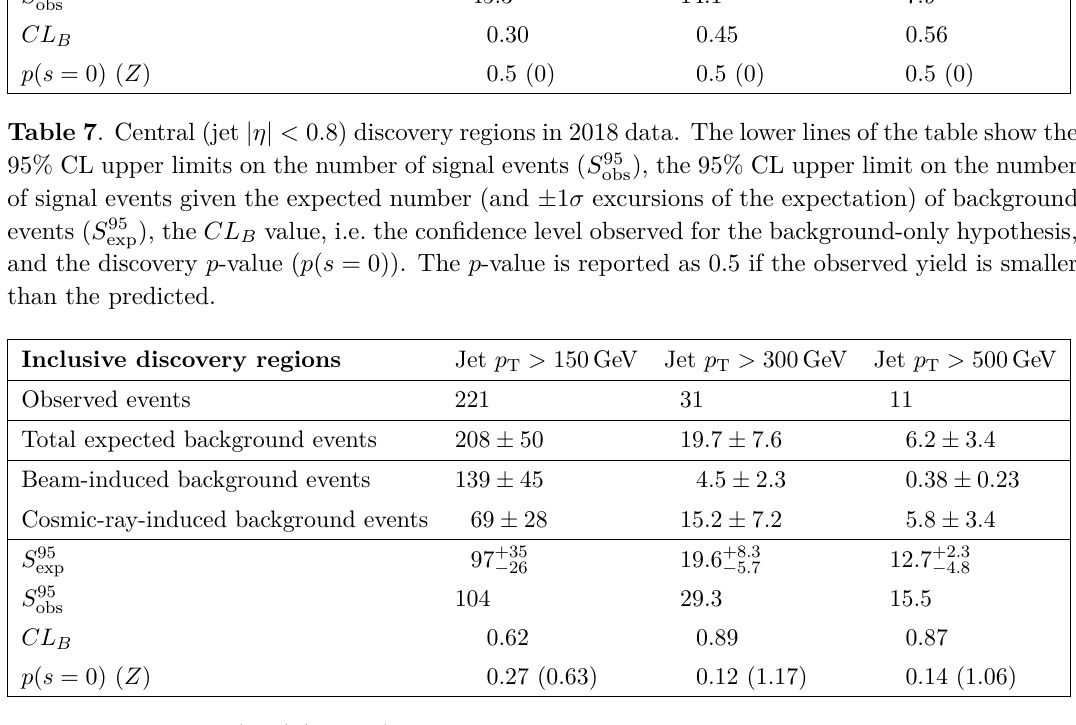
Table 8 . Inclusive (jet | η | < 2 . 4 ) discovery regions in 2018 data. The lower lines of the table show the 95% CL upper limits on the number of signal events ( S 95 ), the 95% CL upper limit on obs the number of signal events given the expected number (and ± 1 σ excursions of the expectation) of background events ( S 95 ), the CL value, i.e. the confidence level observed for the background-only B exp hypothesis, and the discovery p -value ( p ( s = 0)